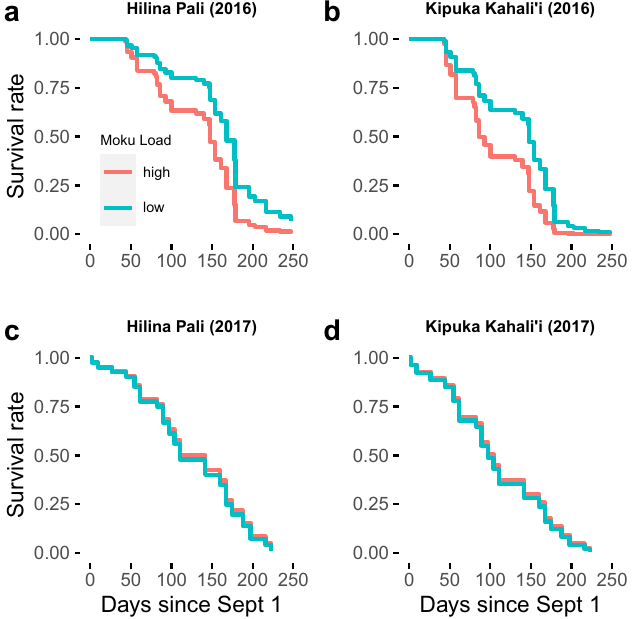
Figure 3. Adjusted survival curves showing the effect of Moku Virus load on survival for wild Vespula pensylvanica colonies in Hawaii Volcanoes National Park. In 2016, colonies with low Moku Virus load survived significantly longer than those with high load (Cox proportional hazards test with additional covariates; Table 1), with the Hilina Pali site (a) having significantly longer survival than the Kīpuka Kahali’i site (b) . Sample sizes in (a) are n = 23 and 27 for high and low load respectively, and in (b) are n = 15 and 9. The effect of Moku Virus was not observed in 2017 in either Hilina Pali (c) or Kīpuka Kahali’i (d) . Sample sizes are n = 25 and 5 for (c) and n = 5 and 1 for (d) , for high and low loads, respectively. These curves are adjusted to account for cox regression model covariates using the ggadjustedcurves() function in the survminer package and the models reported in Table 1.